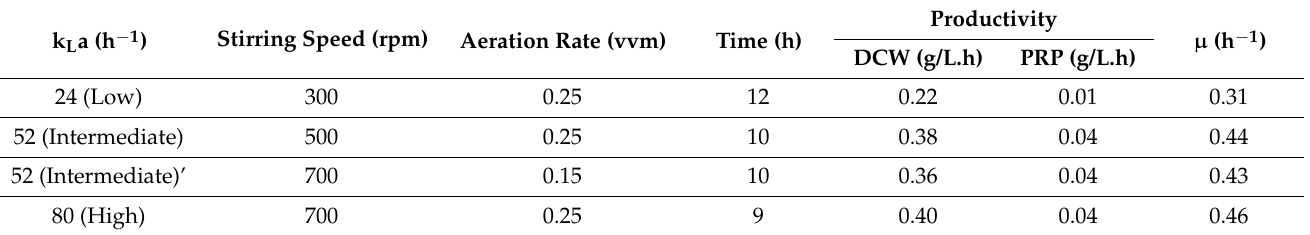
Table 2. Comparison of kinetic parameters obtained from cultures in 1.5 L bioreactor performed with H. influenzae using different k L a values.